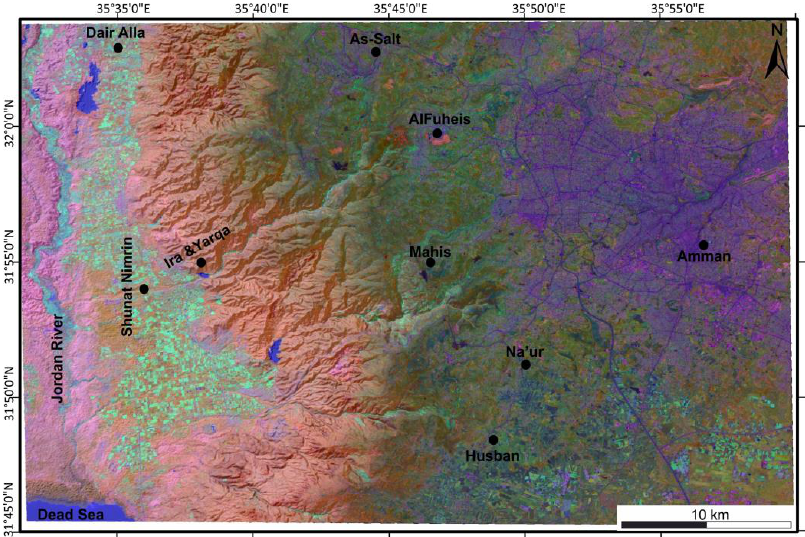
Figure 5. An example of the principal component analysis (PCA) (PC1, PC2, and PC3 in R, G, and B) developed with Landsat-8 OLI Bands 6, 5, and 2. developed with Landsat-8 OLI Bands 6, 5, and